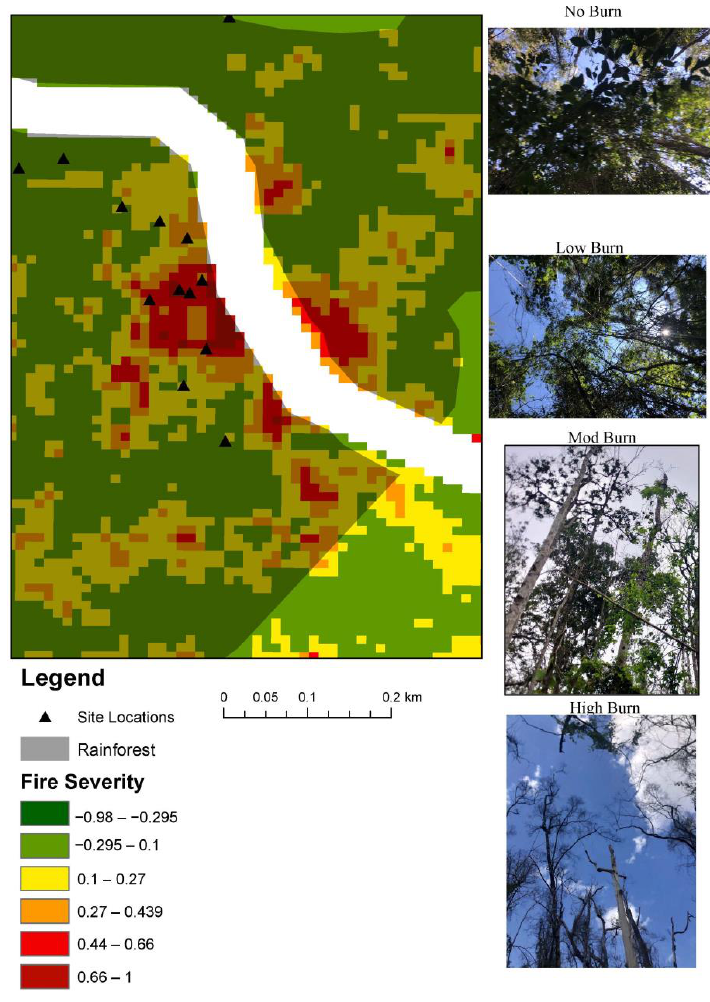
Figure 2. Fire-severity mapping displaying dNBR, rainforest polygon, and site locations. Images taken at different fire-severity sites for Rainforest. No burn sites had no scorches present on the trunk, understorey was dense, sub-canopy and canopy were full (1st photo). Low burn sites were identified through minimal burn in the understorey and a full canopy (2nd photo). Moderate burn sites were determined through increased height of scorched trunks up to the shrub layer and occasionally the sub-canopy (3rd photo). High burn was identified by the loss of canopy and minimal regeneration in all stratum layers (4th